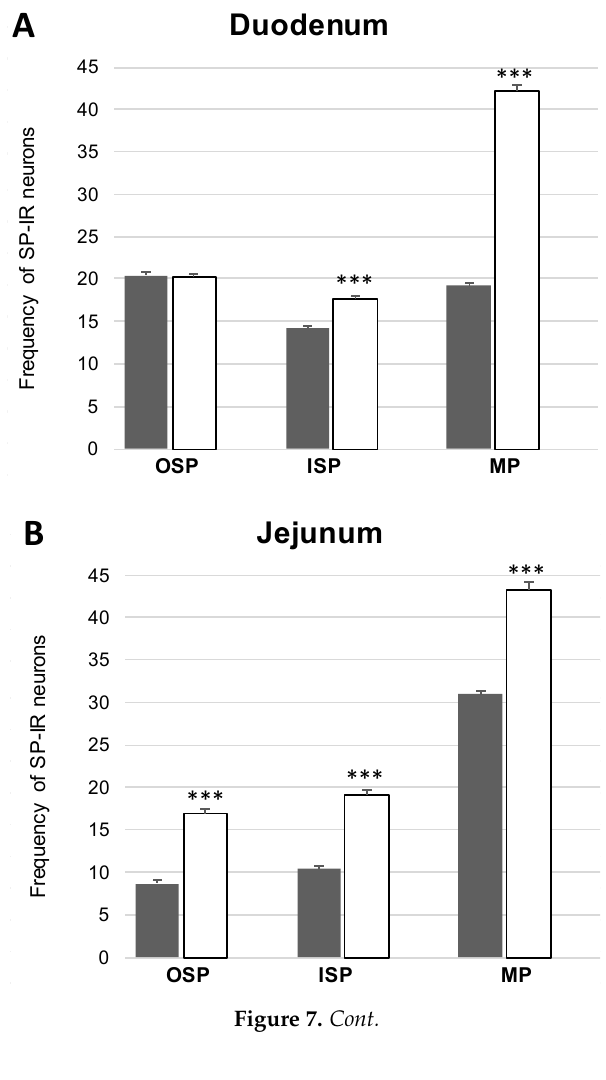
Figure 6. Intramural plexuses in the duodenum, jejunum and ileum immunoreactive to nNOS and GAL. Myenteric plexus in the duodenum ( A , D ), jejunum ( B , E ) and ileum ( C , F ) under physiological conditions (A–C) and after streptozotocin administration (D–F). All photographs were created by digital superimposition of two-colour channels (green for nNOS and red for GAL). Neurons showing co-localization of nNOS and GAL are indicated with arrows. Outer submucosal plexus in the duodenum ( G , J ), jejunum ( H , K ) and ileum ( I , L ) under physiological conditions (G–I) and after streptozotocin administration (J–L). All photographs have been created by digital superimposition of two-colour channels (green for nNOS and red for GAL). Neurons showing co-localization nNOS and GAL are indicated with arrows. Inner submucosal plexus in the duodenum ( M , P ), jejunum ( N , R ) and ileum ( O , S ) under physiological conditions (M–O) and after streptozotocin administration (P–S). All photographs were created by digital superimposition of two-colour channels (green for nNOS and red for GAL). Neurons showing co-localization of nNOS and GAL are indicated with arrows.